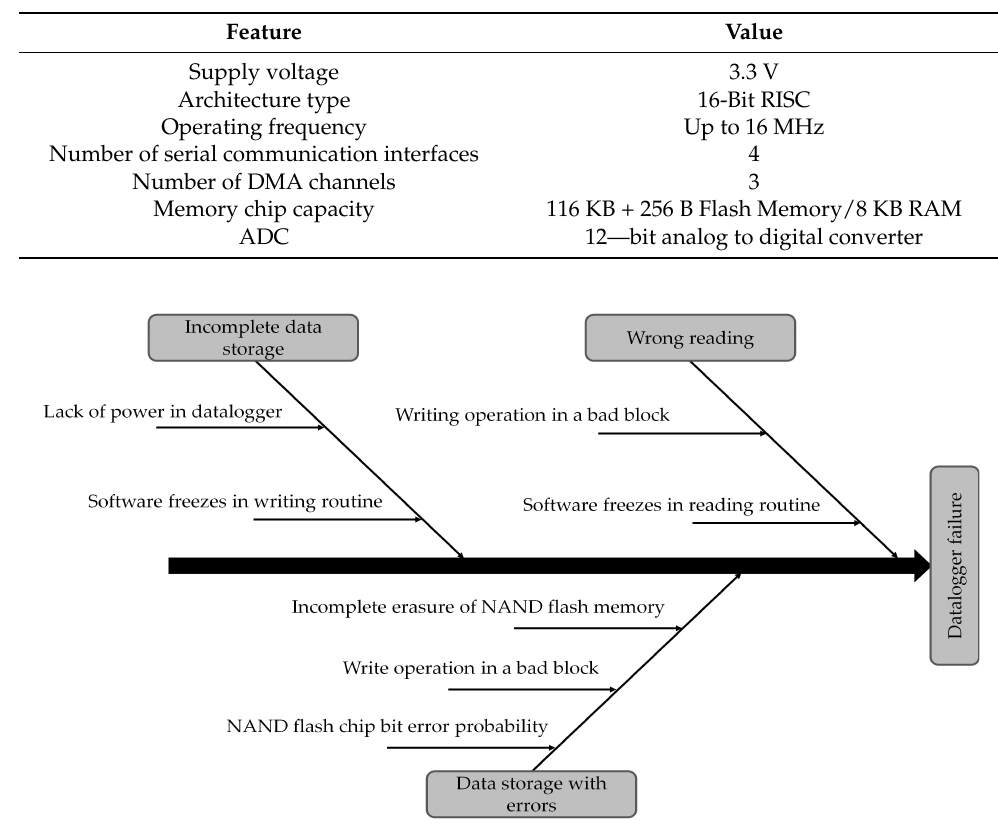
Table 3. Microcontroller features summary.